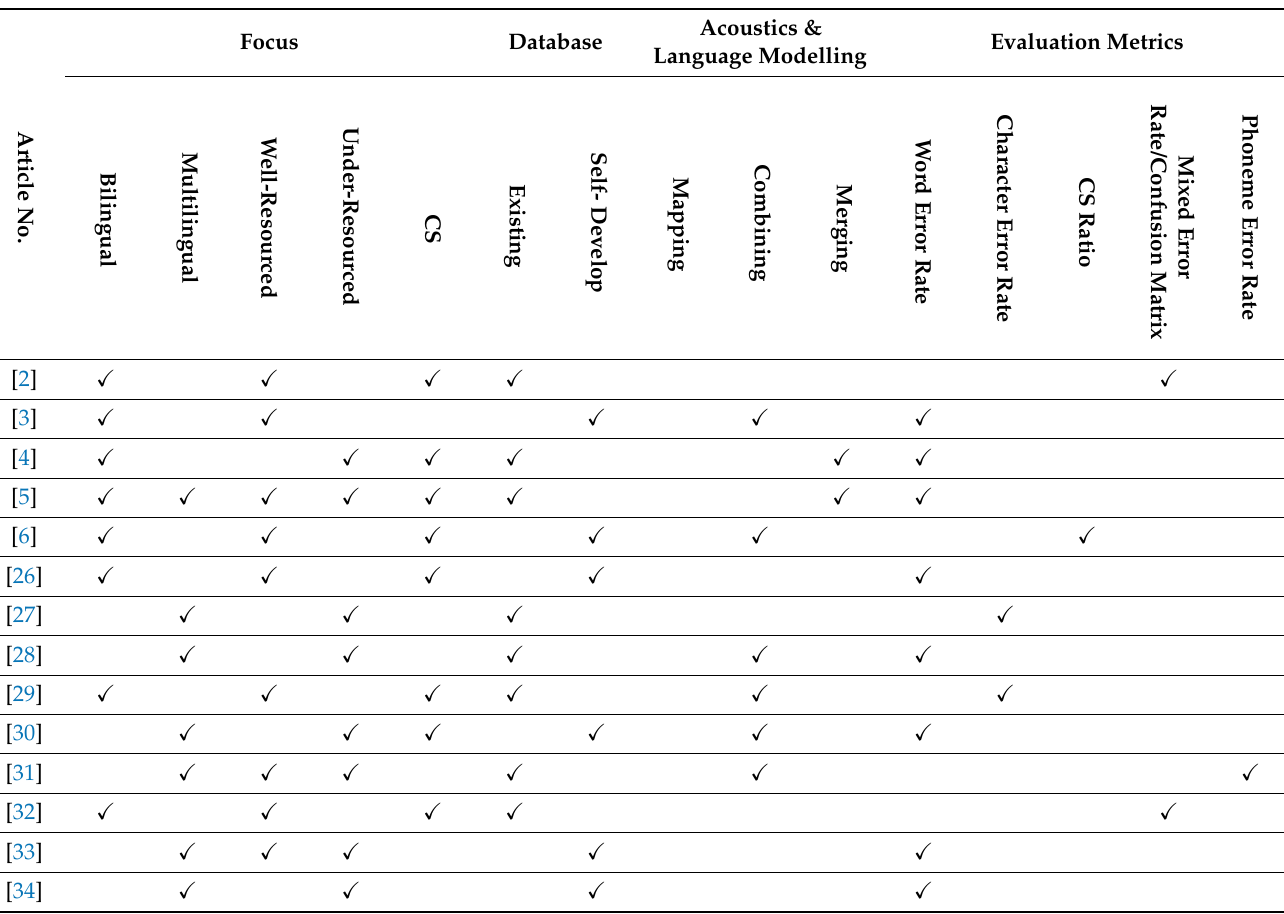
Table 1. Direction of the papers in terms of focus, databases, acoustics and language modelling, and evaluation